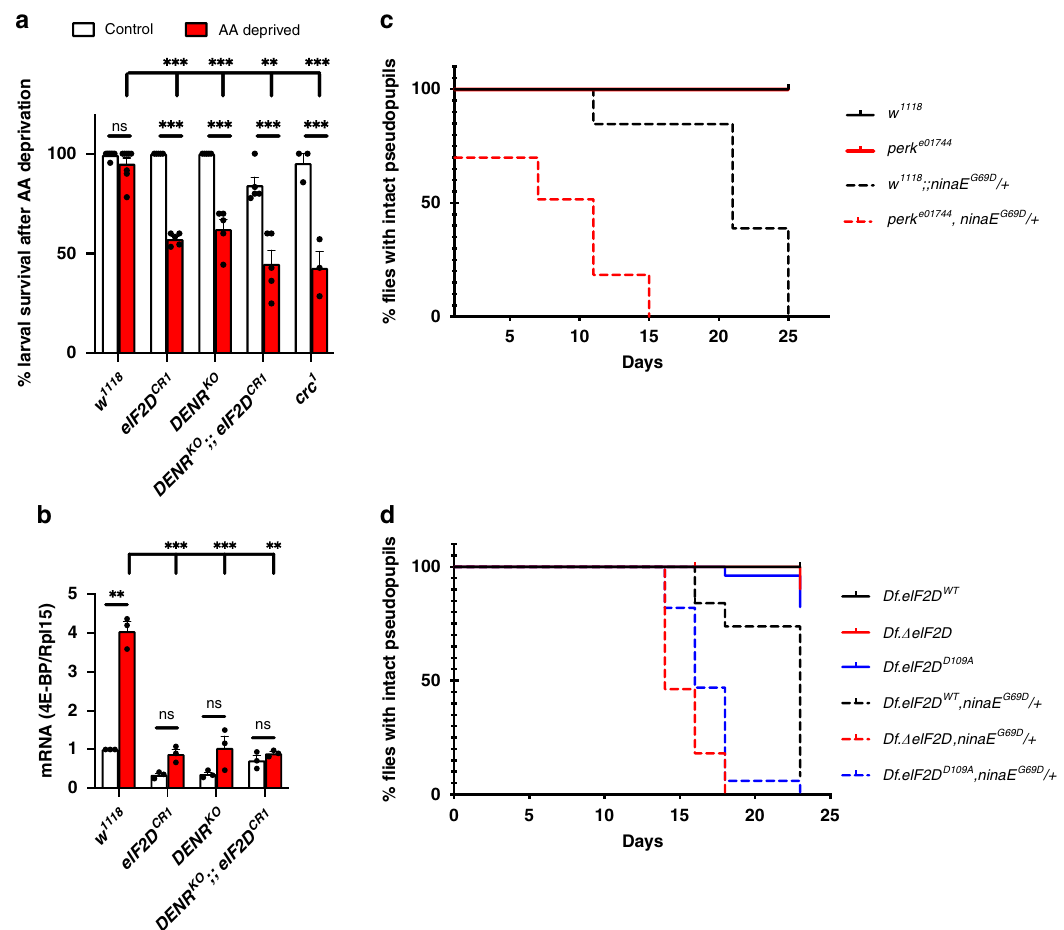
Fig. 5 eIF2D and DENR modulate stress response phenotypes. a Survival rate of second instar larvae of the indicated genotypes when fed with normal food (white bars) or amino acid deprived food (4% sucrose, red bars) for 8 h. Data represent the mean from fi ve independent experiments with 20 animals in each trial, and error bars represent standard error. b qPCR analysis of 4E-BP mRNA levels in larvae from a . Data are the mean from three independent experiments, with error bars representing standard error. In both a, b , p values were calculated using the two-tailed t -test with ** p < 0.001, *** p < 0.0001 and n.s. not signi fi cant. c Photoreceptor degeneration in the ninaE G69D / + adRP model in control and perk mutants as assessed by Rh1-GFP fl uorescence that allows for visualization of photoreceptors in adult pseudopupils. Note that the lines for w 1118 (solid black) and perk e01744 (solid red) overlap. The difference in the course of retinal degeneration between the following pairs is statistically signi fi cant as assessed by the Log-rank (Mantel-Cox) test ( p < 0.0001): w 1118 and w 1118 ;;ninaE G69D / + , perk e01744 and perk e01744 ,ninaE G69D / + , w 1118 ;;ninaE G69D / + and perk e01744 ,ninaE G69D / + . ( n = 100). d Photoreceptor degeneration with ninaE G69D / + monitored in various eIF2D mutant backgrounds. Note that the curves for the control Df.eIF2D WT (solid black), Df. Δ eIF2D (solid red) and Df.eIF2D D109A (solid blue) overlap for the early time points. The difference in the course of retinal degeneration between the following pairs is statistically signi fi cant as assessed by Log-rank (Mantel-Cox) test ( p < 0.0001): Df.eIF2D WT and Df.eIF2D WT ,ninaE G69D / + , Df. Δ eIF2D and Df. Δ eIF2D, ninaE G69D / + , Df. Δ eIF2D and Df. Δ eIF2D,ninaE G69D / + , Df.eIF2D WT ,ninaE G69D / + and Df. Δ eIF2D,,ninaE G69D / + , Df.eIF2D WT ,ninaE G69D / + and Df.eIF2D D109A , ninaE G69D / + . ( n = 100). Please see Source Data Files for the raw data in a – d